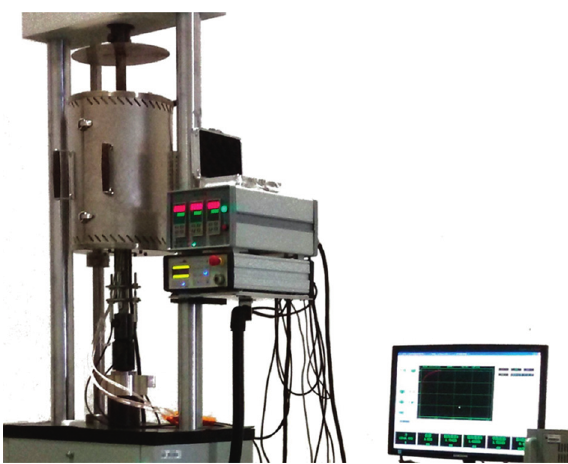
Figure 3: Testing system (Doli control